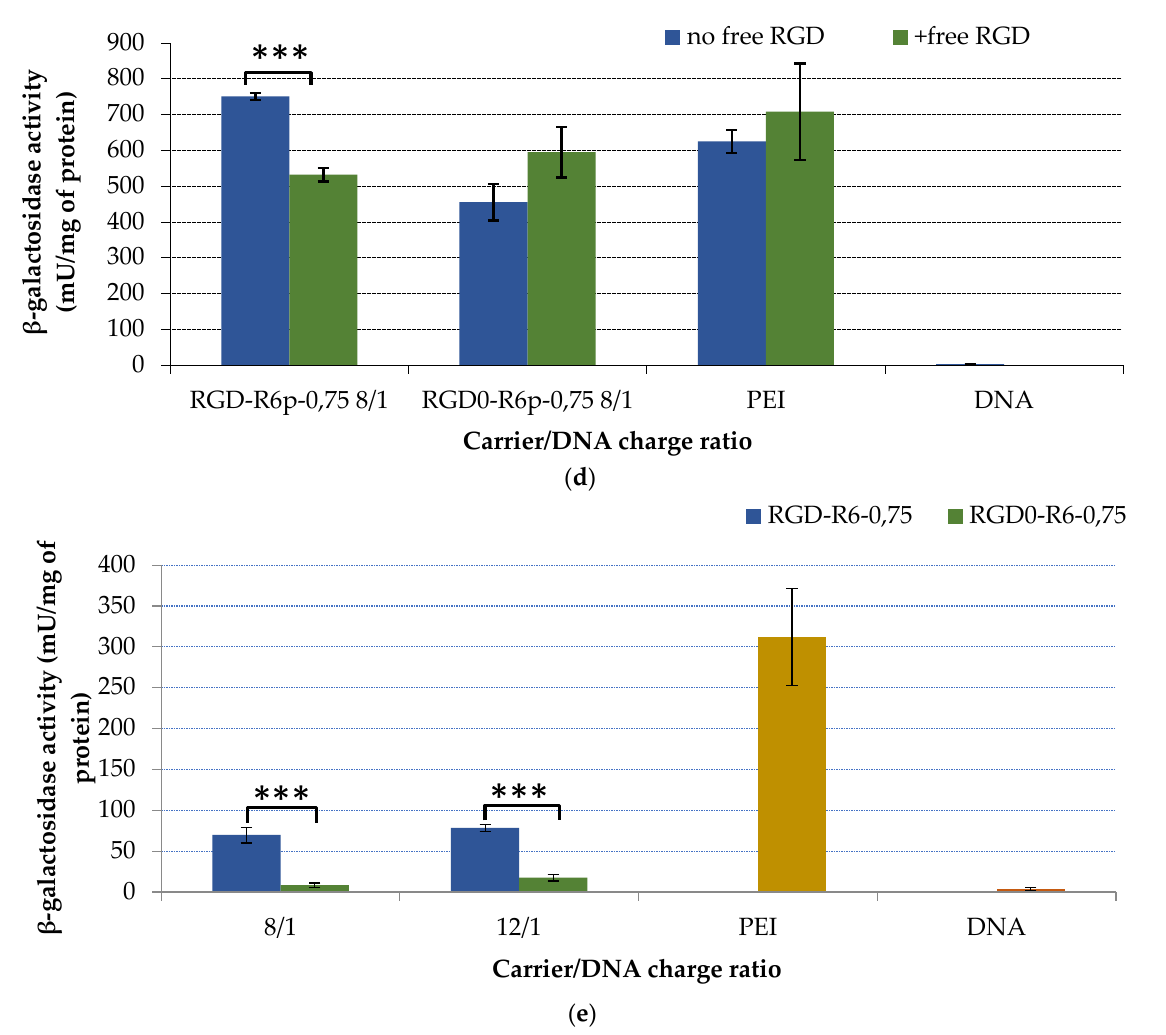
Figure 8. Transfection efficacy studies. The PANC-1 ( a – c ) and 293T ( d ) cells were transfected with RGD-R6p-0,75/DNA and RGD0-R6p-0,75/DNA polyplexes at 8/1 and 12/1 charge ratios with pCMV-LacZ plasmid ( a , d , e ) and pEXPR-IBA5-eGFP plasmid ( b , c ). A 10-fold excess of free cRGD molecules were added to the cells for competition transfection studies ( d ). Reporter lacZ gene expression is given as milliunits (mU) per milligram of protein ( a , d , e ). GFP gene expression is given as a percentage of GFP-positive cells according to flow cytometry ( b ). The typical appearance of GFP-positive cells is shown on fluorescent microscopic images ( c ). Values are the mean ± SEM of the mean of triplicates (** p < 0.01, *** p < 0.001). Additionally, to demonstrate the specificity of RGD-R6p-0,75/DNA polyplexes for targeted gene delivery we assessed the effect of free cyclic RGD (cRGD) molecules on RGD-R6p-0,75/DNA complexes formed at an 8/1 charge ratio in the presence of a 10-fold excess of cRGD peptide (Figure 8c). The cells’ pre-treatment with cRGD resulted in a